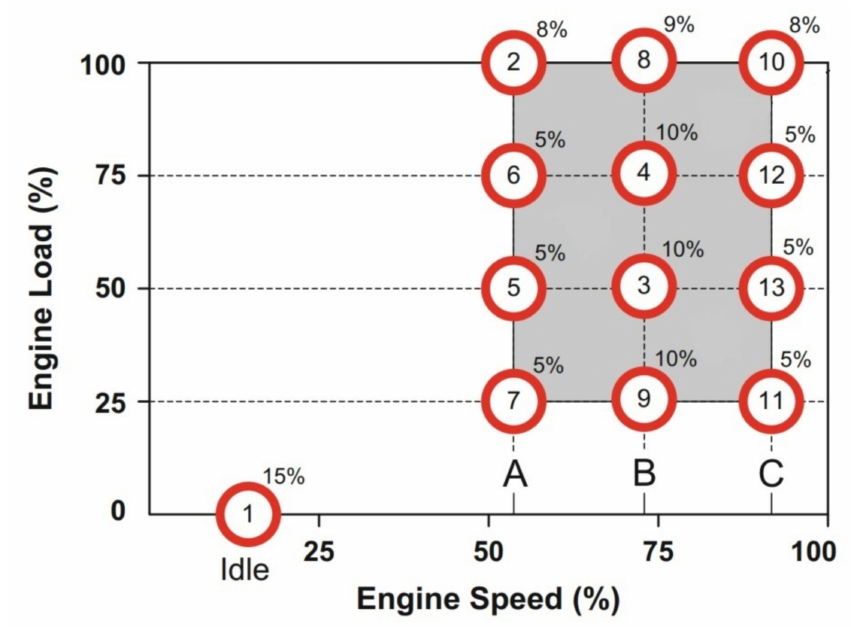
Figure 12. European Stationary Cycle (ESC) with the order of the measurement points and their relative weight (%)